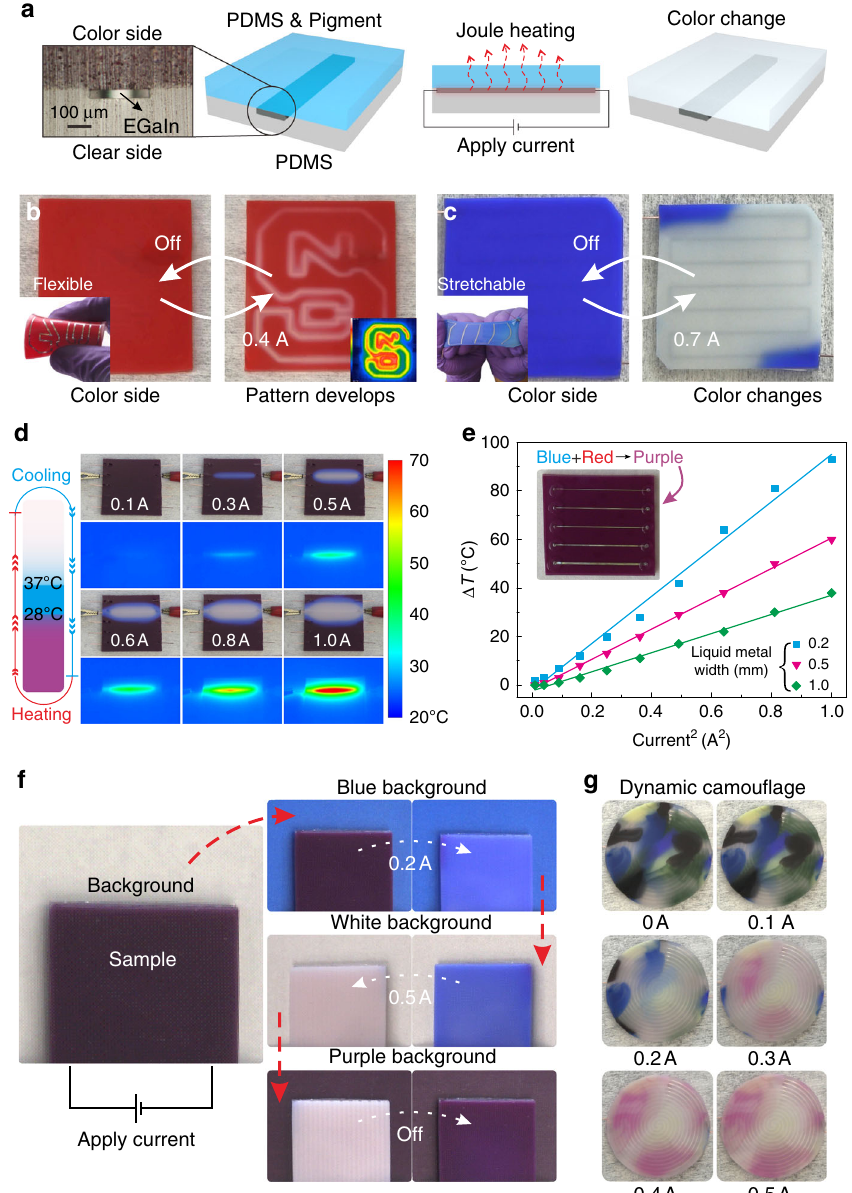
Fig. 1 A platform for materials logic via pigmented silicones innervated with liquid metal. Liquid metals patterned within an elastomer can Joule heat to invoke color changes. a Schematic of a simple device consisting of a liquid metal circuit between two layers of PDMS. Joule heating causes color change of the pigment in the PDMS. b Localized Joule heating changes the color from red to white, resulting in a passive display. c A device with blue thermochromic completely changes color to white in response to electrical current. d Photographs of a sample with blue and red pigments that change color in response to current. The images under the photographs are IR images. e Plot of max temperature versus current squared ( Δ T is surface temperature minus room temperature). The lines are best fi ts of the experimental data. The inset photograph shows the device with both red (1.2 wt%) and blue thermochromic (0.8 wt%). The dimensions of the linear microchannels are 50 mm length; 0.05 mm height; X mm width ( X = 0.2, 0.3, 0.4, 0.5, and 1.0). f Modulating applied current allows the device to change colors to match the background. g Patterning dye in the elastomer can create multi-colored camou fl age